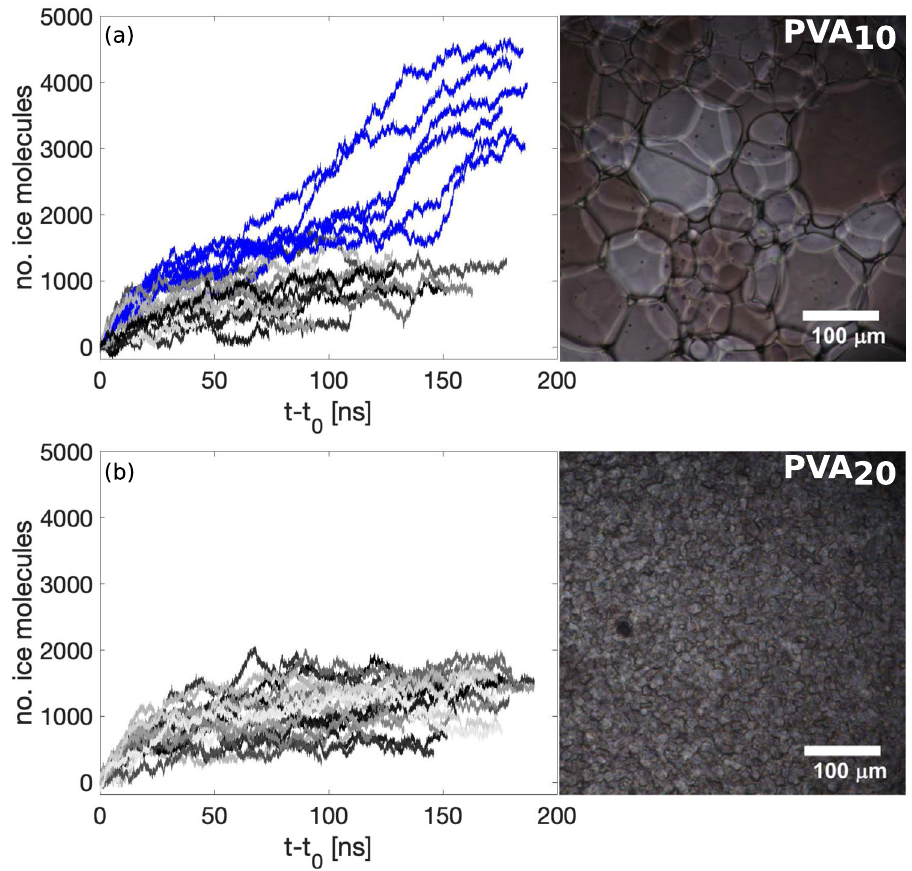
Fig. 5 Comparison between the IRI activity of PVA 10 and PVA 20 . The IRI activity of PVA is quanti fi ed in terms of the evolution of the number of molecules within the growing ice front as a function of time. t 0 represents the time at which 20% of the hydroxyl groups on the polymer chain have bound to ice. The results of our MD simulations (left) are complemented by micro-graphs (right) obtained via splat assays experiments. a PVA 10 : note the sharp increase in the number of ice molecules for those simulations (corresponding to the blue lines) in which PVA 10 becomes overgrown by the ice phase. b PVA 20 : note the clear plateauing of the ice growth once PVA 20 has bound to the ice front. The results of the splat assays illustrate the dramatic difference in terms of the mean size of the ice crystals observes in the presence of either PVA 10 and PVA 20 – consistently with our MD simulations. NATURE COMMUNICATIONS| (2021) 12:1323